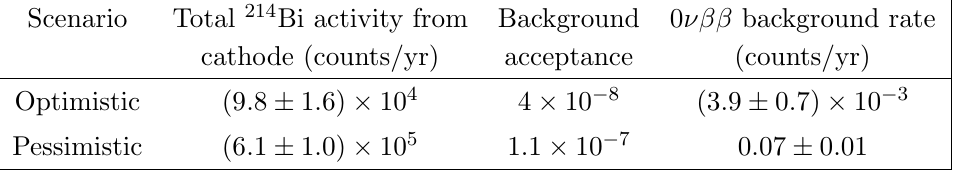
Table 6 . Radon-induced background rates expected in NEXT-100 under di(cid:11)erent assumptions. The 222 Rn-induced total 214 Bi activity from the cathode given in the table is the same as the one measured in NEXT-White during period A1 in the optimistic scenario, while it is assumed to scale as the detector surface area in the pessimistic scenario. The background acceptances and background rates refer to the 0 (cid:23)(cid:12)(cid:12)